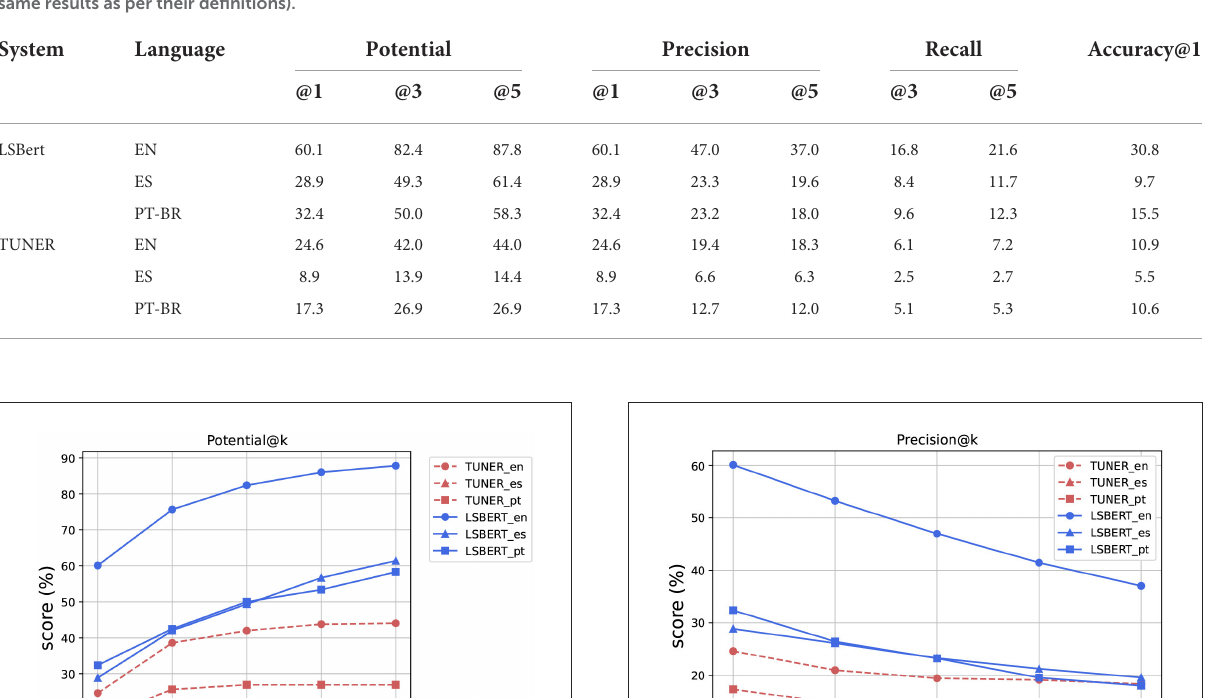
TABLE 5 Features of the BERT-based models used in the LSBert approach for each language. Language Model Type Case Layers #parameters English BERT-WWM BERT-large-wwm uncased 24 336M BETO BERT-base-wwm uncased BERT-base